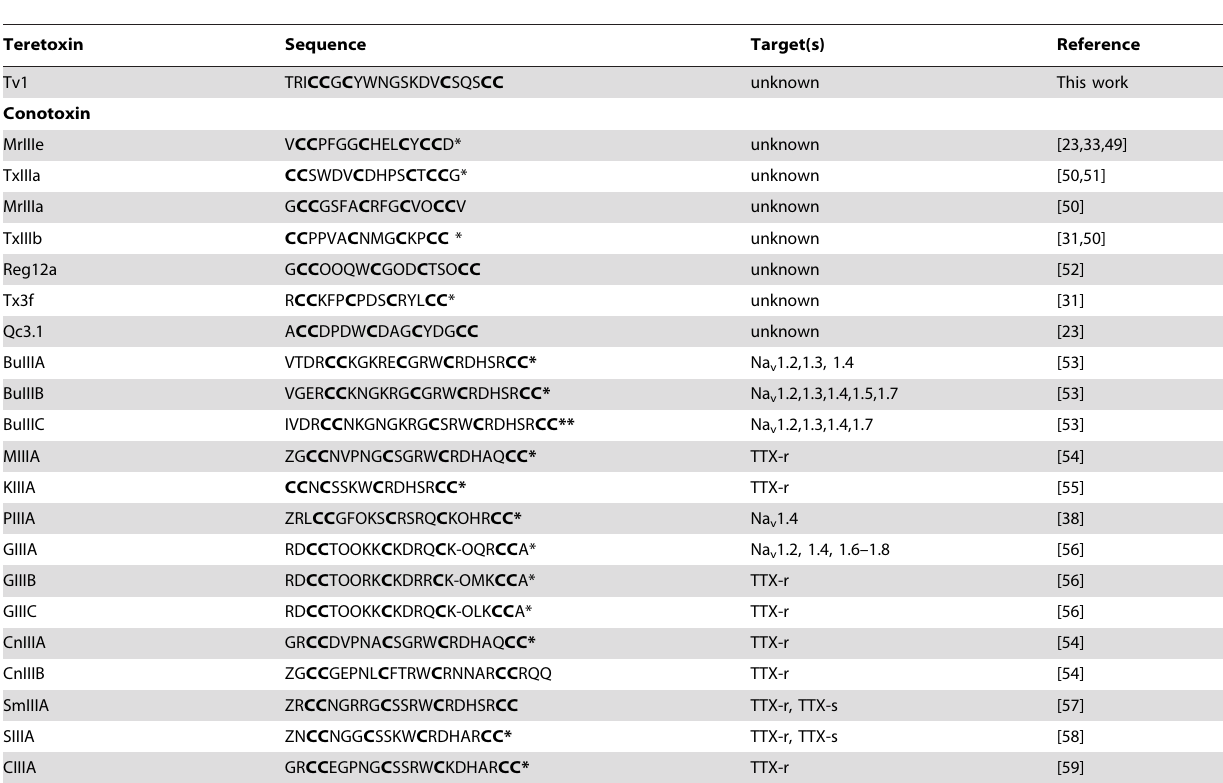
Table 1. Comparison of Teretoxin Tv1 and known M superfamily